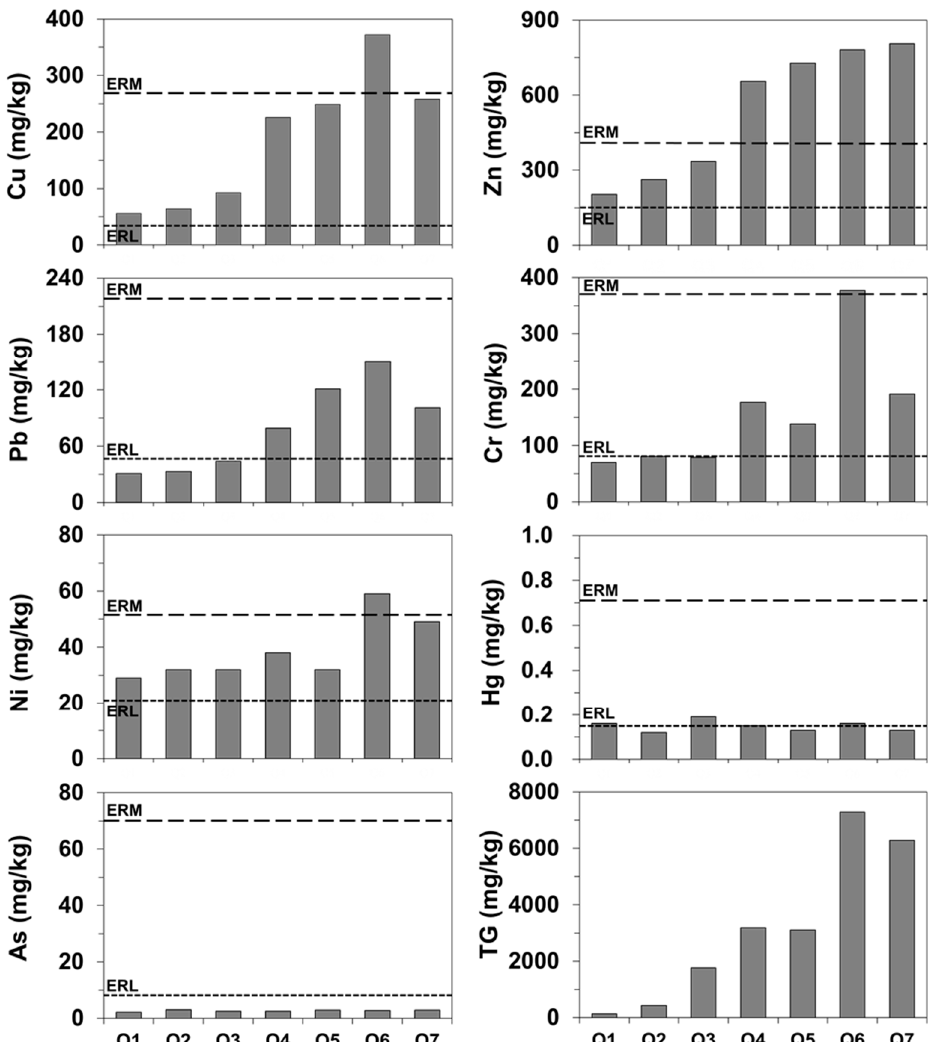
Figure 2. Variations in heavy metals (Cu, Zn, Pb, Cr, Pb, Ni, Hg, As) and total grease (TG) in Qianzhen Fishing Port sediments. Horizontal dotted and dashed lines indicate the values of ERL and ERM , respectively.